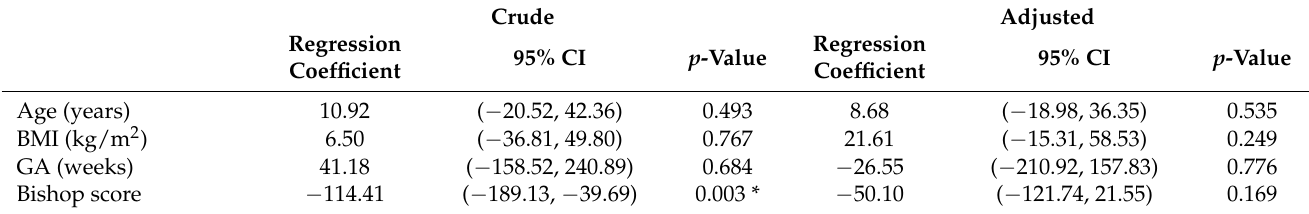
Table 4. Factors associated with total labor time (n =